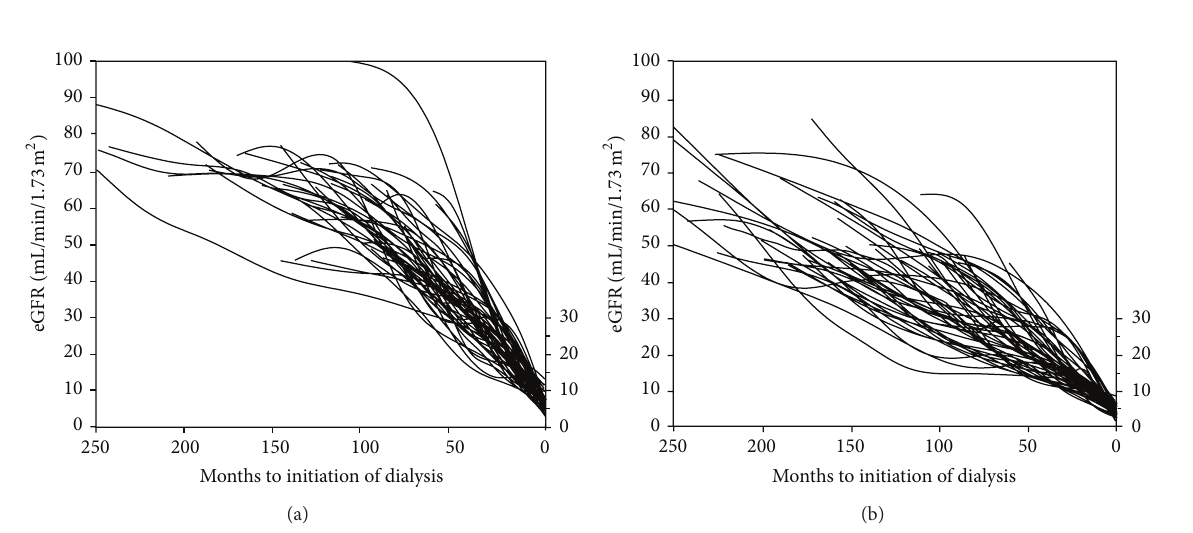
Figure 1: Estimated glomerular filtration rate (eGFR) trajectories with individual slopes during the observation period in the two groups. (a) Smoothing curve for the diabetic nephropathy group; (b) smoothing curve for the nephrosclerosis group.